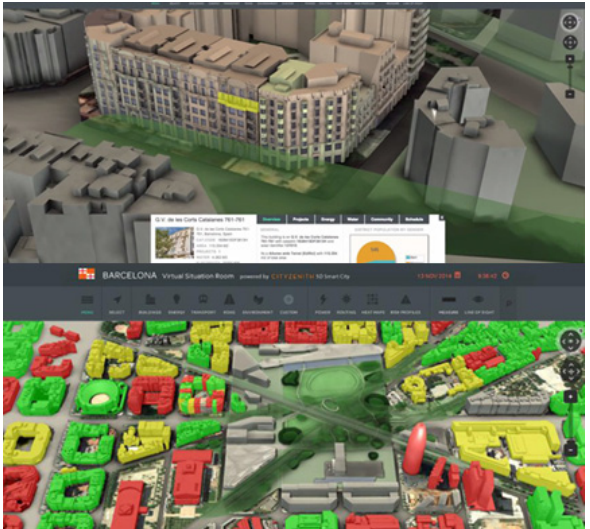
Figure 4. 3D model of Barcelona by 5D Smart City. Figure courtesy of 5D Smart